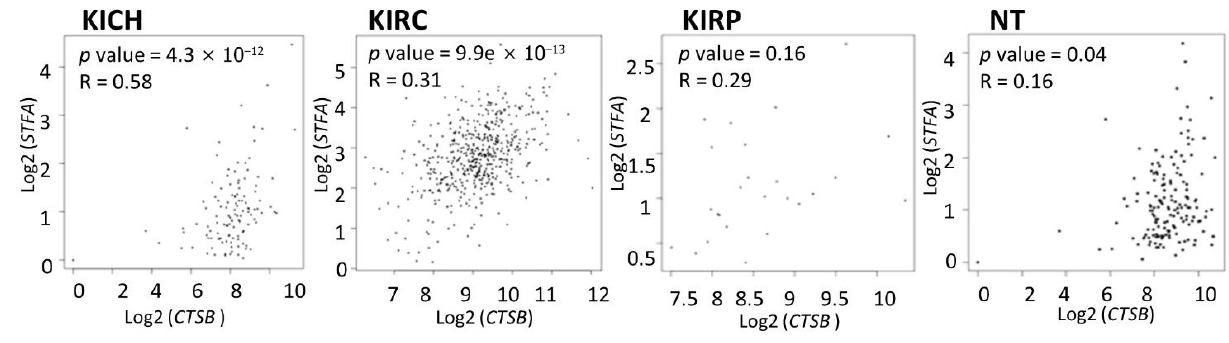
Figure 2. CTSB and STFA share similar expression patterns in renal cell carcinoma and normal kidney tissues (NT) ranked by the Pearson correlation coefficient. GEPIA provides a pairwise CTSB / STFA gene correlation analysis for given sets of TCGA and/or GTEx expression data in the correlation graphs. Individual points upon which the correlation is calculated are a single value of multiple